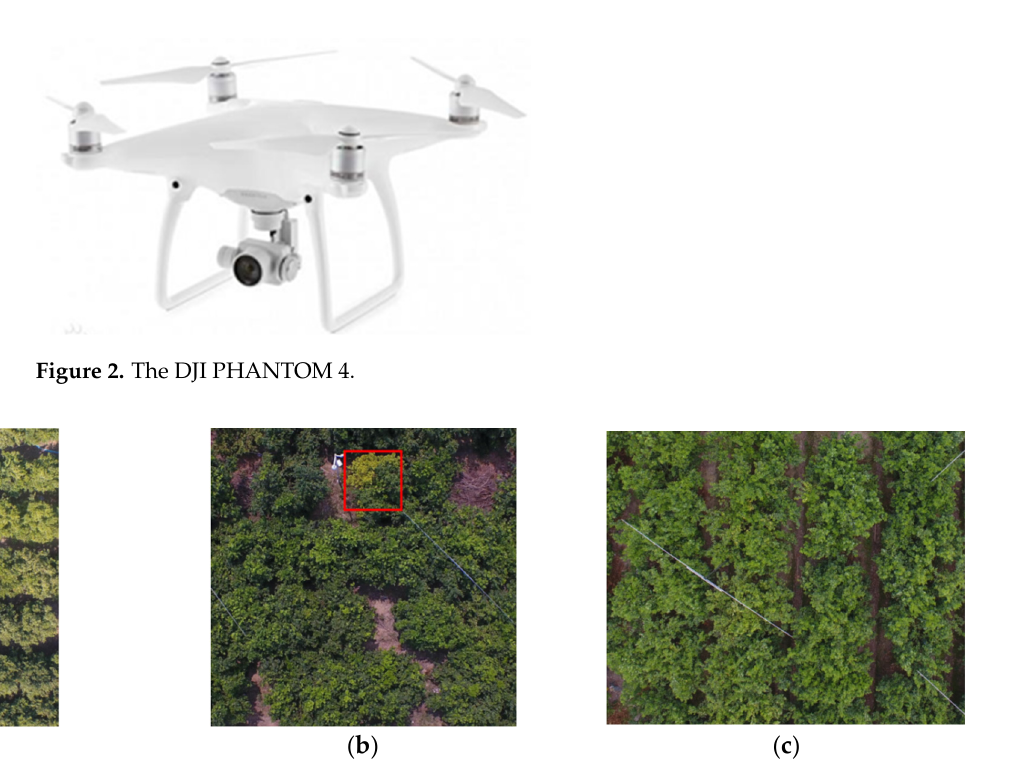
Figure 3. The red squares in figure ( a , b ) are ( a ) Uneven planting or felled areas, ( b ) yellow suspected plant; ( c ) normal citrus tree.